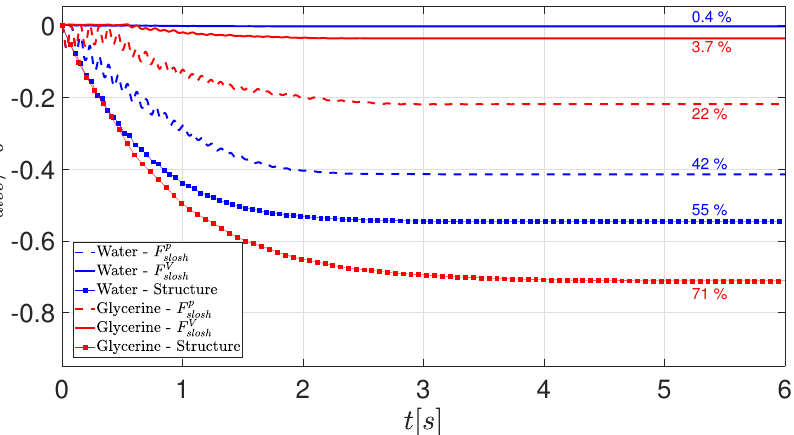
Figure 17. Normalized dissipated energy by the pressure and viscous components of the sloshing force and the structural damping force coming from the linear